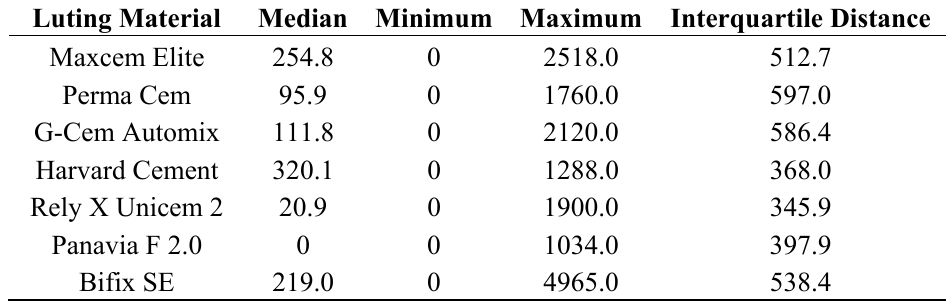
Table 2. Descriptive data of the statistical evaluation of microleakage independent from the location of the preparation in μ m.